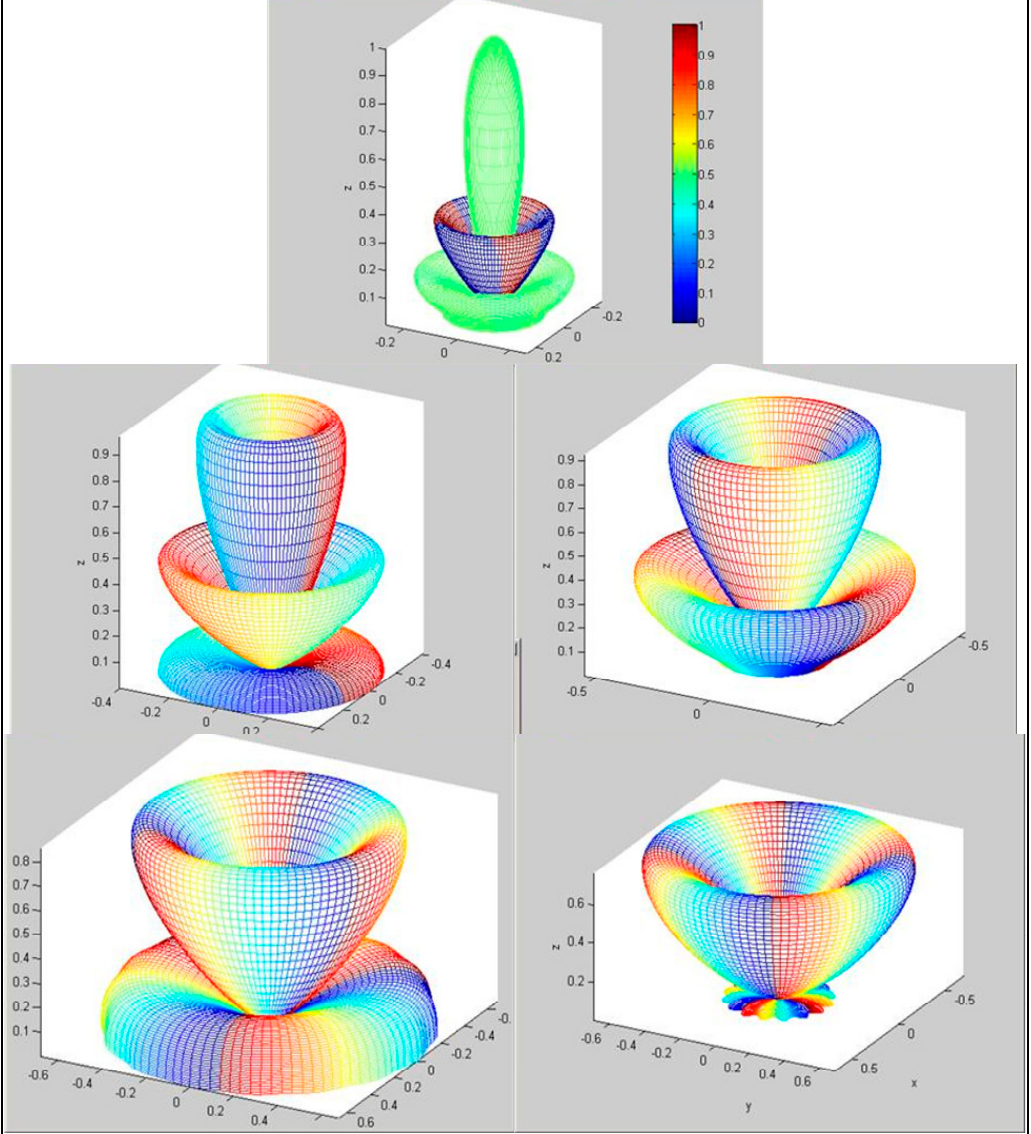
Figure 2. Far-field beam patterns of OAM modes k = 0 (top), 1, 2, 3, 4.